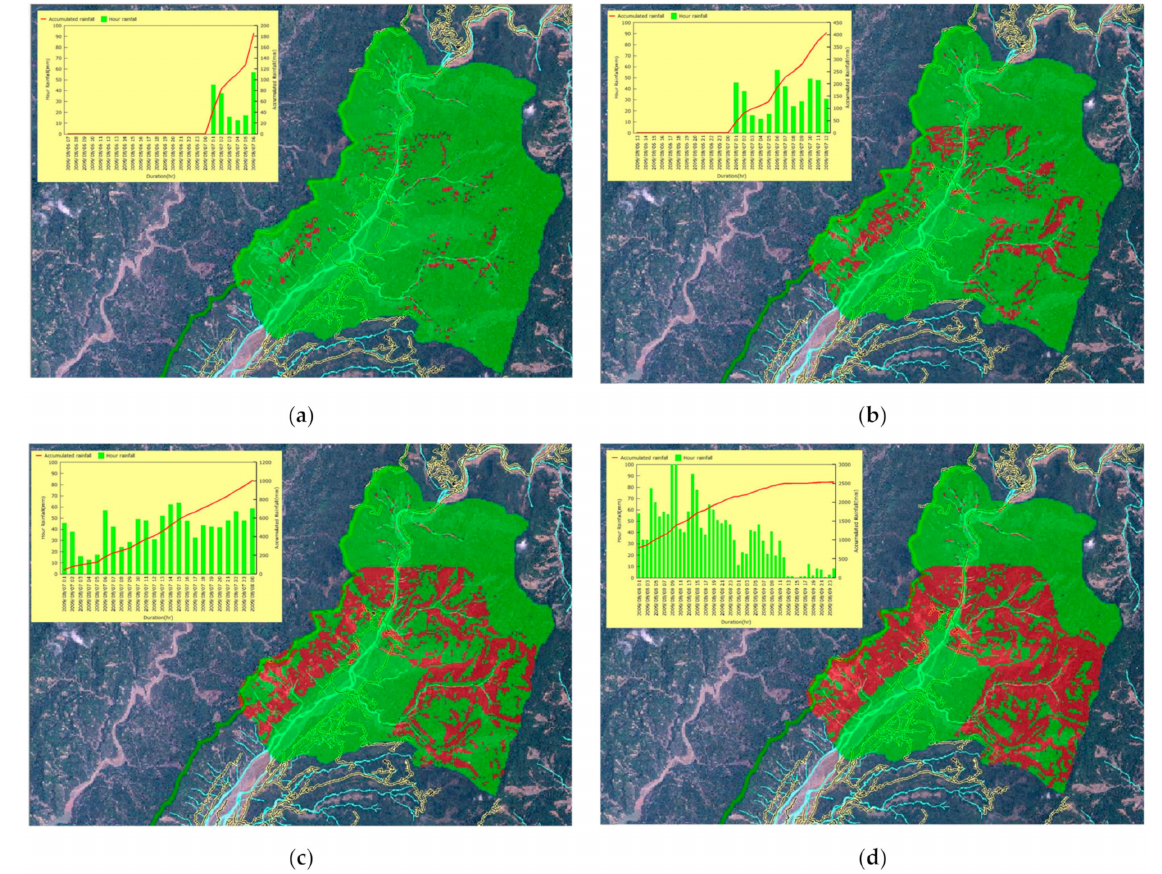
Figure 7. The real-time regional landslide-susceptibility display during Typhoon Morakot. ( a ) 06:00 on 7 August 2009. ( b ) 12:00 on 7 August 2009. ( c ) 00:00 on 8 August 2009. ( d ) 00:00 on 10 August